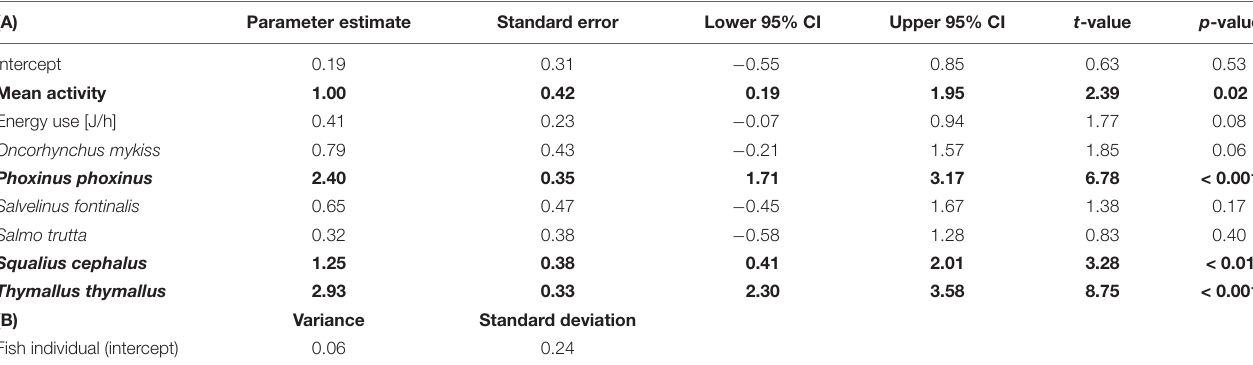
TABLE 6 | The highest weight ( ω = 0.52) GLMM (model #3) describing the measured eDNA copy numbers via (A) the fixed effects: mean activity, energy use and fish species identity, and (B) the random effect fish individual (31 groups, σ = 0.88).